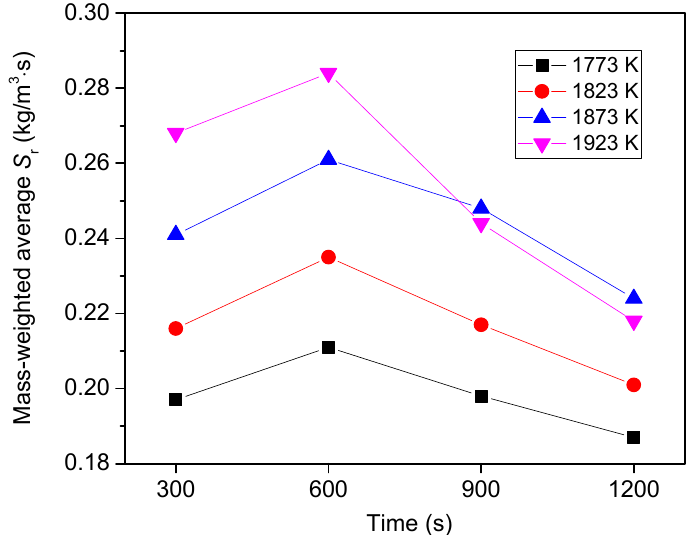
Figure 16. E ff ect of heating temperature on mass-weighted average transfer rate of